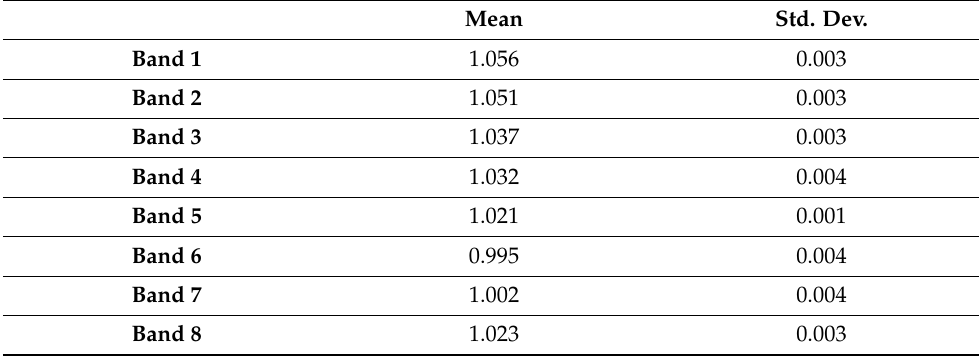
Table 6. Weighted variance